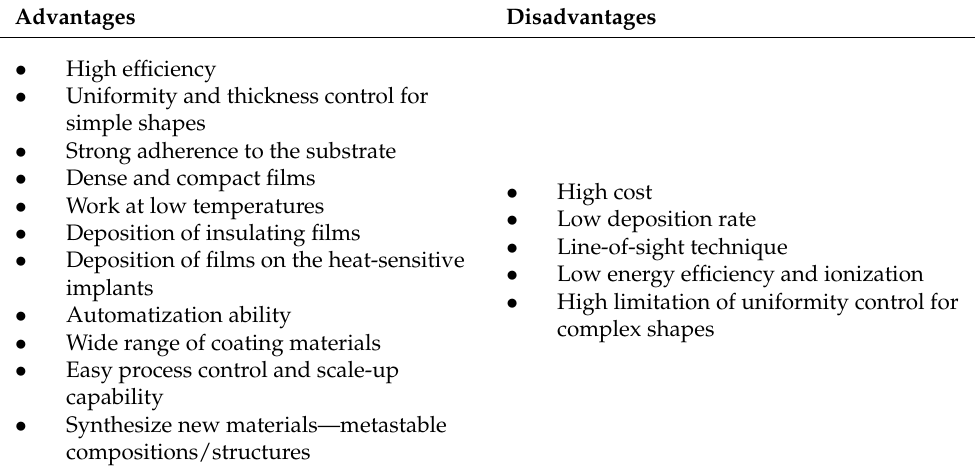
Table 4. Magnetron sputtering advantages/disadvantages